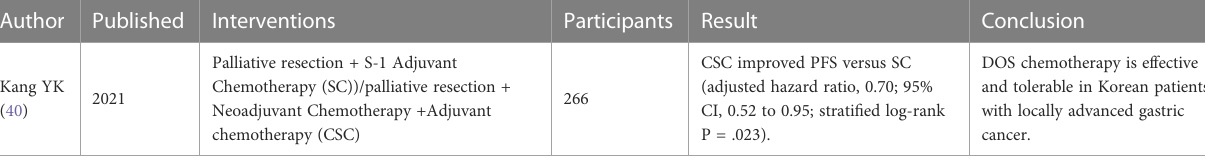
TABLE 1 Recent clinical trials of palliative gastrectomy on palliative treatment of advanced GC.